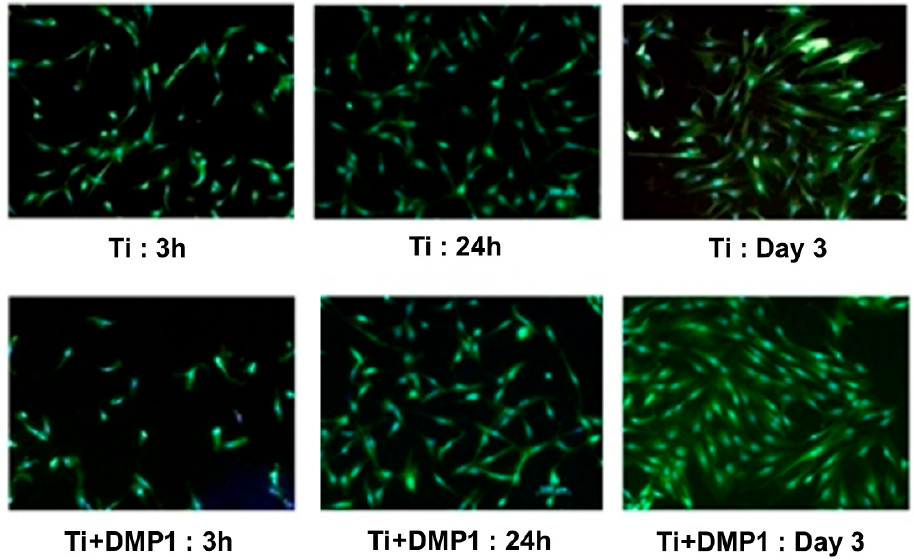
Figure 3. Fluorescence microscopic images of attach cell and cell proliferation assay absorbance for titanium coated and control disks at 3 and 24 h and Day 3.